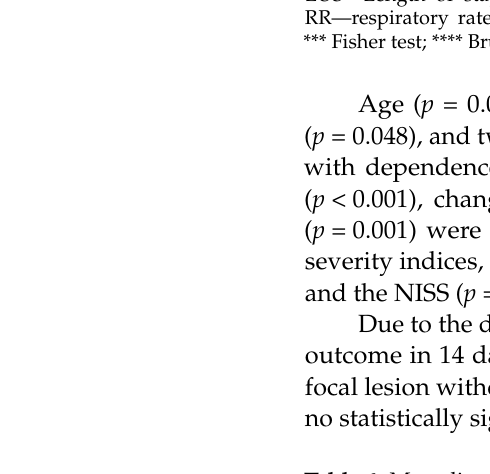
Table 6. Mortality and dependence based on TBI